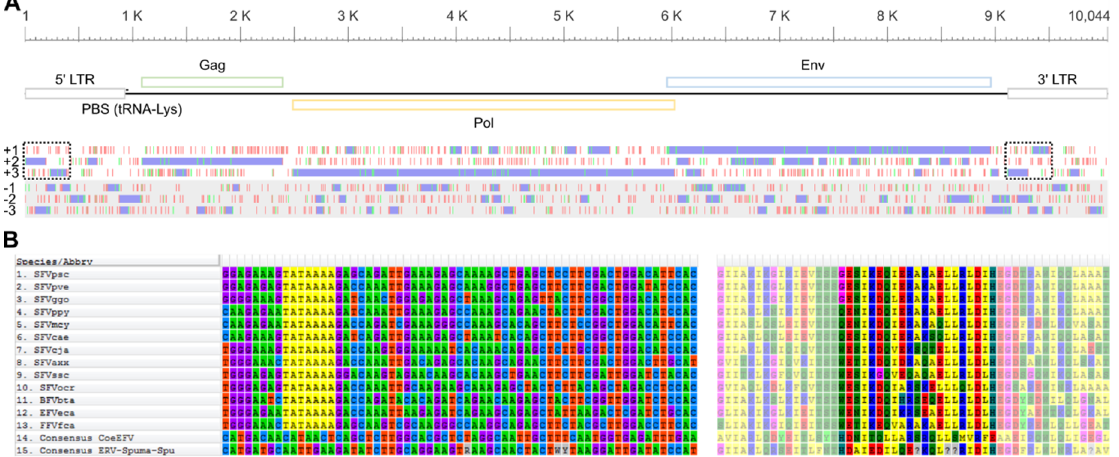
Figure 1. Reconstructed, putative, ERV-Spuma-Spu genome ( A ) and foamy virus (FV) internal promoters ( B ). Top-A, scale bar indicates nucleotide position. Middle-A, schematic diagram representing the genomic organisation of ERV-Spuma-Spu. LTR: long terminal repeat (grey); PBS: primer binging site; Gag: group antigen gene (green); Pol: polymerase gene (yellow); Env: envelope gene (blue). Bottom-A, start (green) and stop (red) codon positions in the six translation frames (+1, +2, +3, − 1, − 2, and − 3). Potential open reading frames are shown in purple. The dotted boxes indicate the two open reading frames identified as a single accessory gene in [8]. The nucleotide sequences of